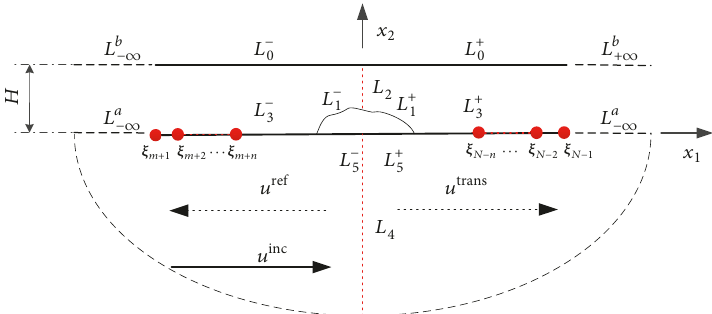
Figure 2: Schematic definition of the computational domain of the Love-wave scattered field, with divided interface boundaries 𝐿 = 𝐿 𝑏 ±∞ ∪ 𝐿 ± ∪ 𝐿 ± ∪ 𝐿 ± ∪ 𝐿 ± ∪ 𝐿 𝑎 0 3 1 5 ±∞ .